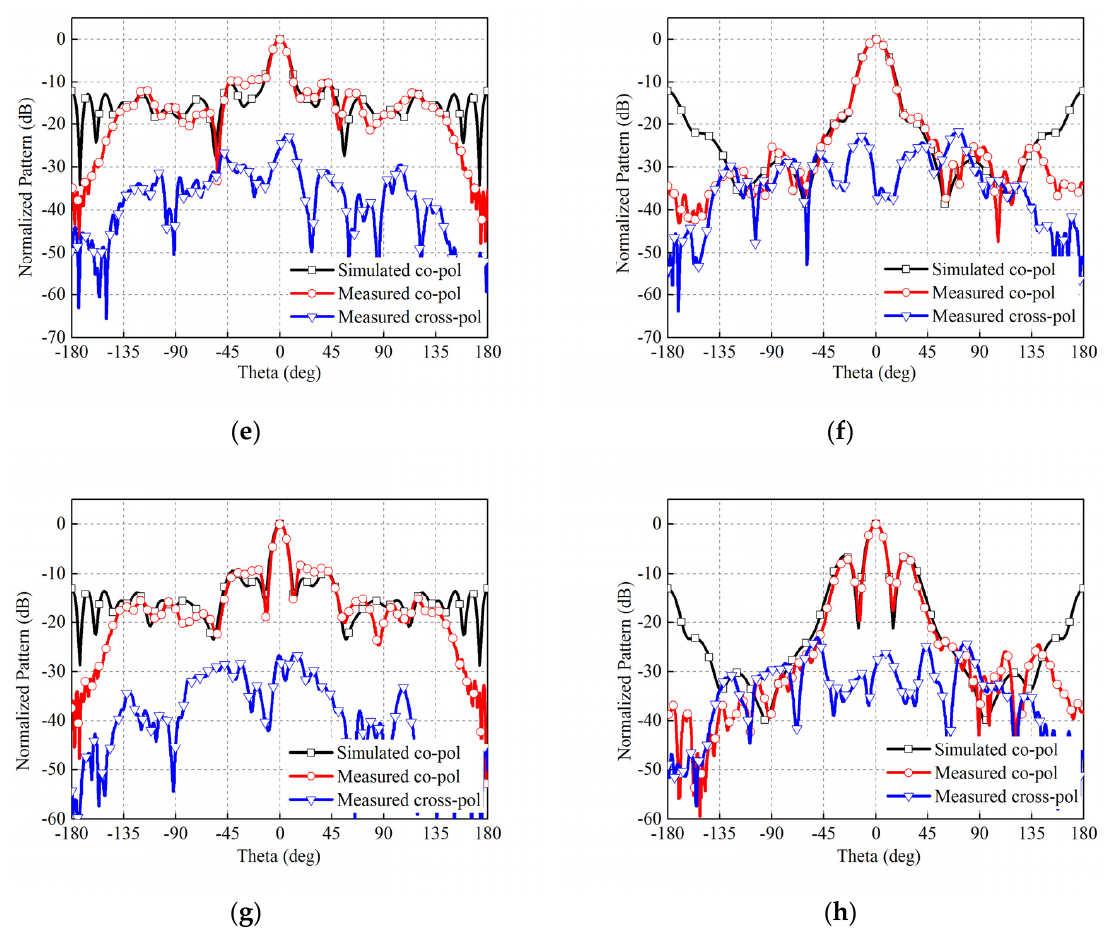
Figure 10. Normalized radiation patterns of the proposed FPRA: ( a ) E ‐ plane at 5.8 GHz; ( b ) H ‐ plane at 5.8 GHz; ( c ) E ‐ plane at 6 GHz; ( d ) H ‐ plane at 6 GHz; ( e ) E ‐ plane at 6.2 GHz; ( f ) H ‐ plane at 6.2 GHz; ( g ) E ‐ plane at 6.5 GHz; and ( h ) H ‐ plane at 6.5 GHz.